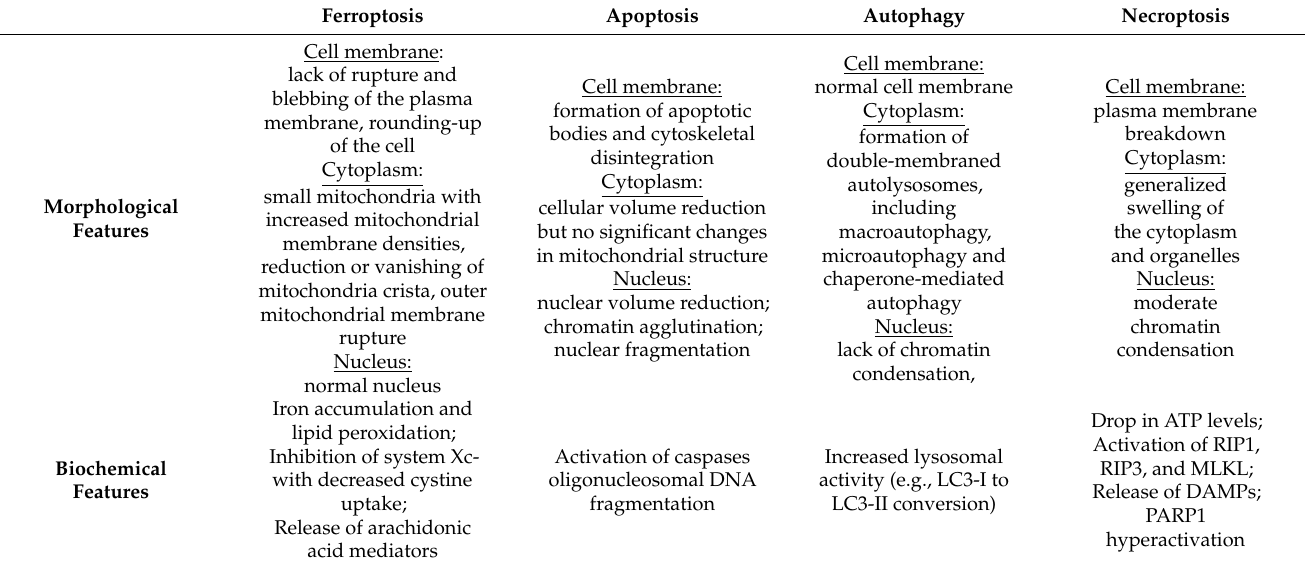
Table 1. The morphological and biochemical features of the different types of cell